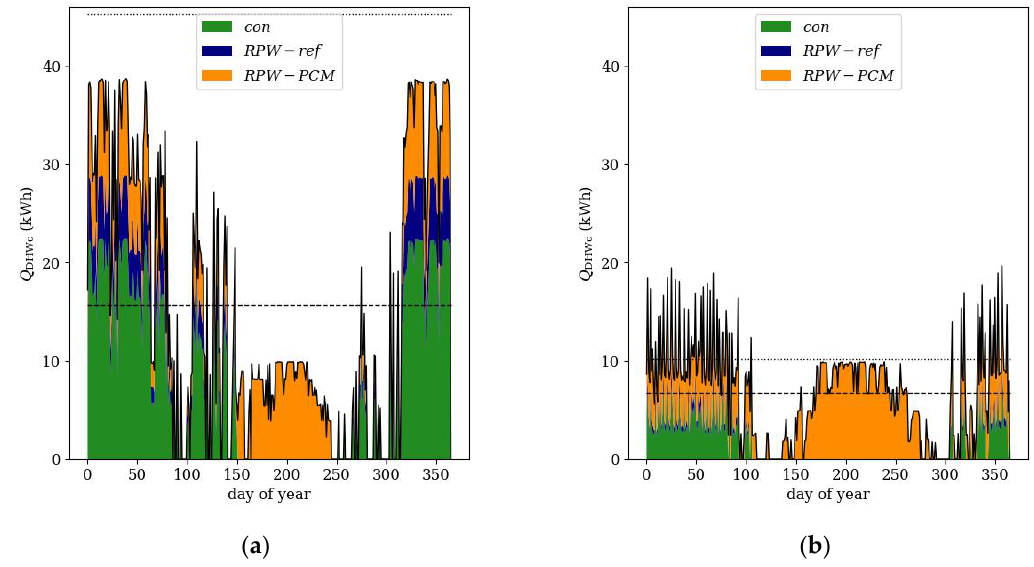
Figure 6. Daily DHW consumption and provided energy for energy efficient DHW generation by operating mode (c) Q DHW,c for ( a ) Case #1 and ( b ) Case #3 and variations from Table 3. The different colors mark the contribution from the condenser (“con”, green), from the refrigerant transferred via the RPW-HEX (“RPW-ref”, blue) and from the energy stored in the PCM-material / aluminum (“RPW-PCM”, orange). The dotted line marks the average DHW consumption and the dashed line mark the average contribution of DHW to the DHW consumption by operating mode (c).